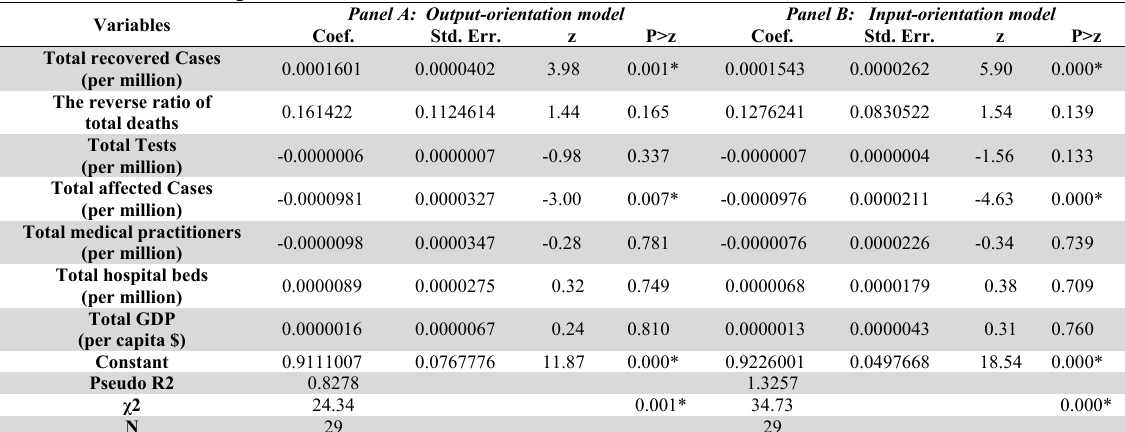
The results of the Tobit